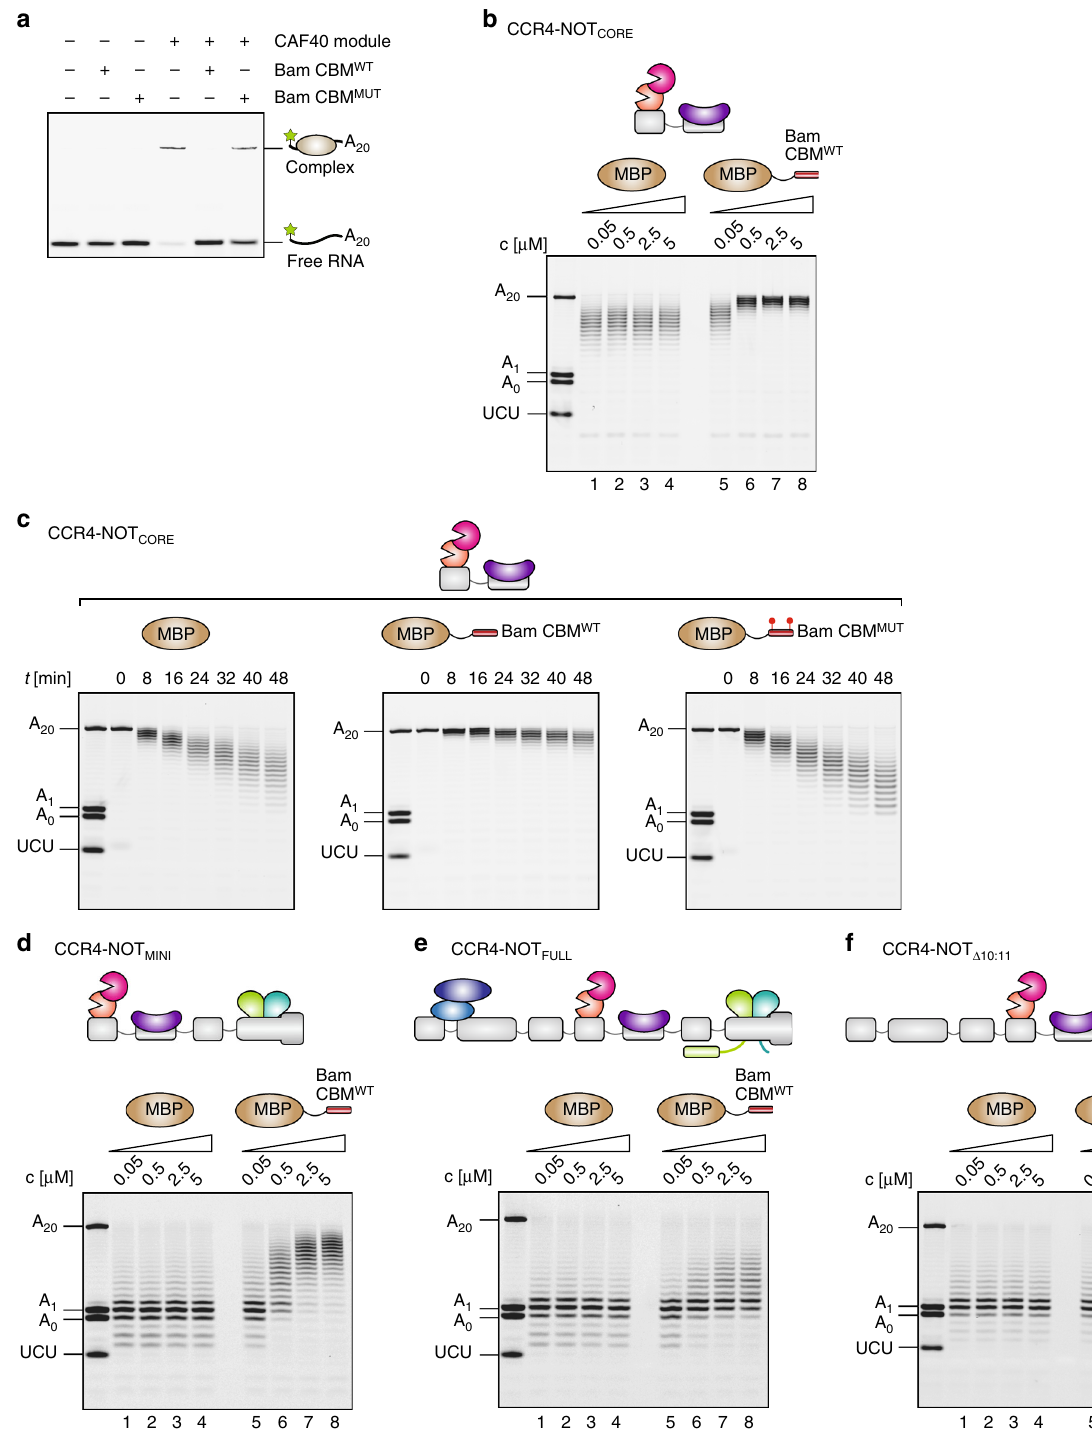
Fig. 4 A peptide motif from Drosophila Bag-of-marbles inhibits deadenylation. a EMSA with the 7-mer-A 20 RNA and the CAF40 module in the absence or presence of MBP-tagged Bam CBM (wildtype or the double mutant). Only Bam CBM WT , but not Bam CBM MUT ef fi ciently competed with RNA for CAF40 binding. b Titration experiment with 50 nM of the 7-mer-A 20 RNA and the CCR4-NOT CORE complex, and the indicated concentrations (0.05 – 5.0 µ M) of either MBP, which served as a negative control, or MBP-tagged Bam CBM WT . A 10-fold excess (500 nM) of Bam CBM WT was suf fi cient to almost completely inhibit deadenylation. The reactions were stopped after 32 min. c Time course assay with the 7-mer-A 20 RNA and the CCR4-NOT CORE complex in equimolar ratio (50 nM). In addition, a 50-fold molar excess (2.5 µ M) of either MBP, which served as a negative control, or MBP-tagged Bam CBM WT or Bam CBM MUT (containing L17E and M24E mutations) were included. d – f Titration experiments with 50 nM of the 7-mer-A 20 RNA and the CCR4-NOT MINI ( d ), CCR4-NOT FULL ( e ) or CCR4-NOT Δ 10:11 ( f ) complexes, respectively, and the indicated concentrations (0.05 – 5.0 µ M) of either MBP, which served as a negative control, or MBP-tagged Bam CBM WT . The reactions were stopped after 32 min. Source data are provided as a Source Data fi